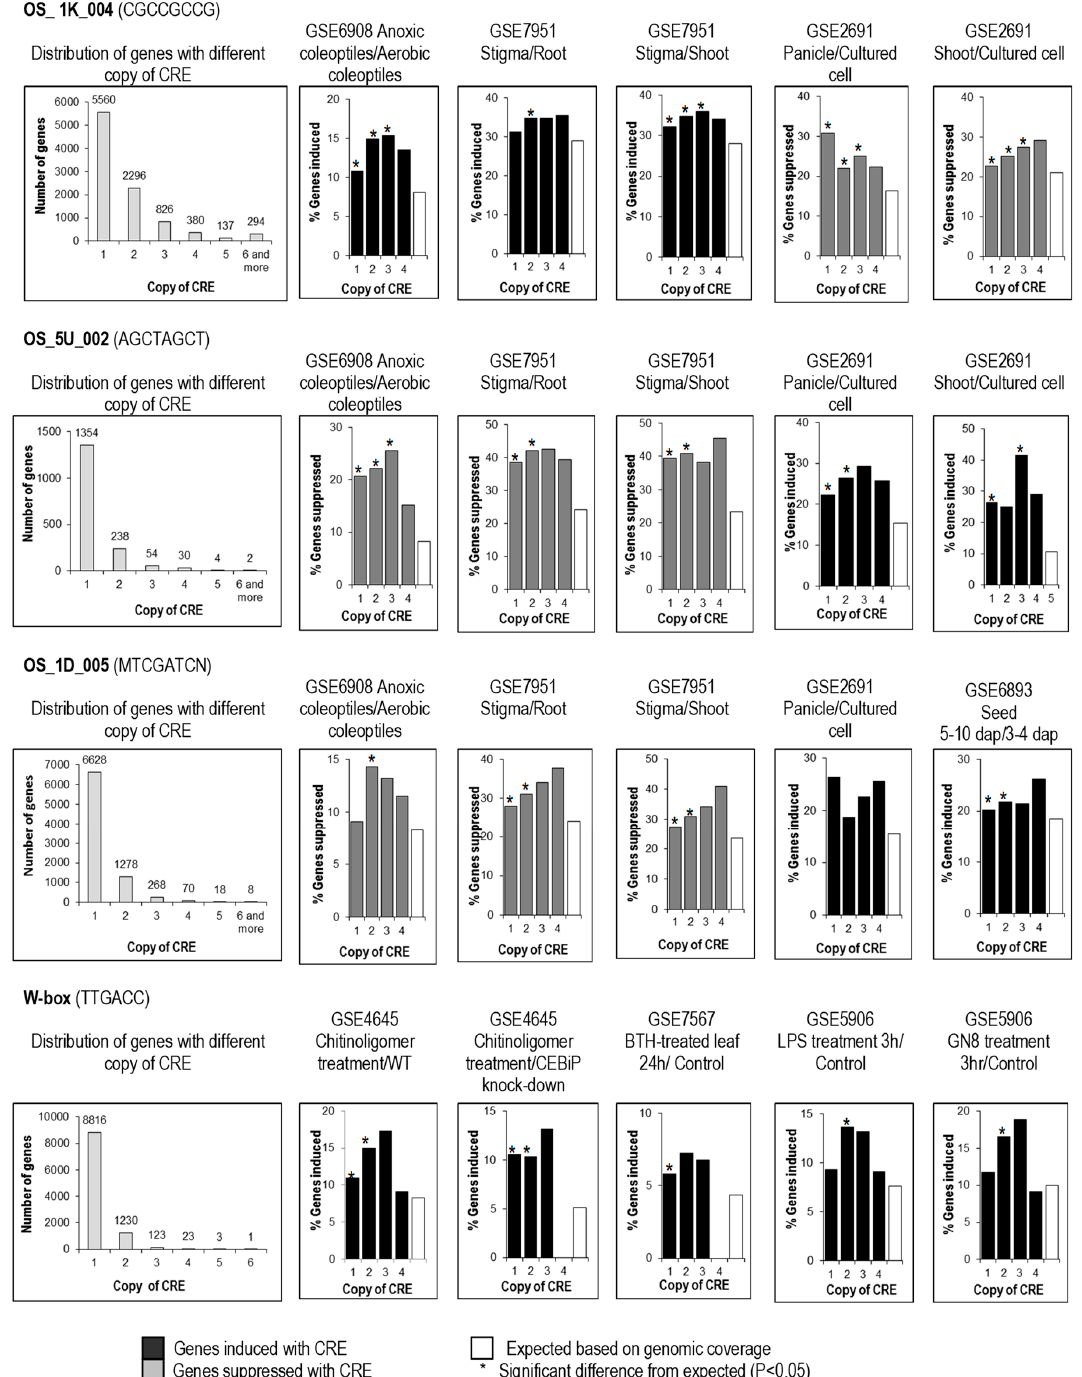
Figure 4. Distribution of genes with different copy numbers of CRE and copy number requirement for effectiveness of CREs. Genes were scored for the number of copies of CRE in their 1-kb upstream sequence from the transcription start site. The number of genes differentially regulated (vertical axis) was calculated in five DNA microarrays. By comparison to expected number regulated genes randomly drawn from the genome (white bars), CREs in different copy numbers (1–4) were scored as having a significant (*; P<0.05) or non-significant effect on regulation in each microarray experiment.